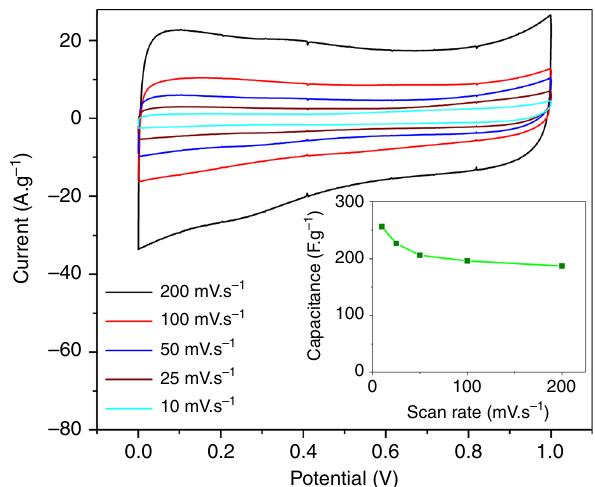
Fig. 5 Supercapacitor behaviour of carbonaceous materials collected from CO 2 conversion. Cyclic voltammograms of a double layer capacitor fabricated from synthesised carbonaceous materials in H 2 SO 4 (1 M) electrolyte. Calculated speci fi c capacitance of the capacitor at various